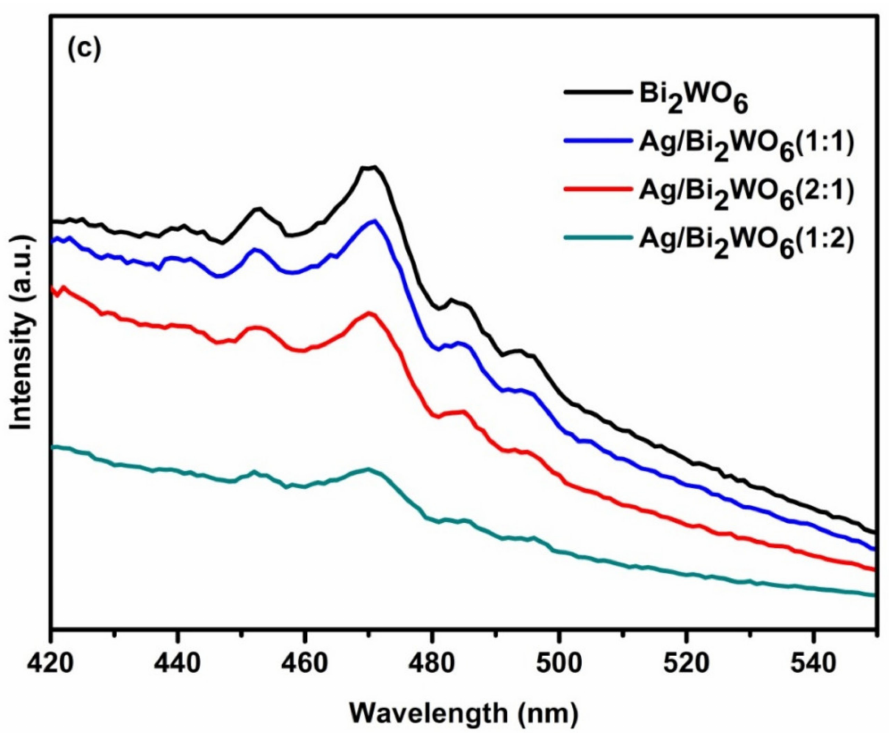
Figure 12. ( a ) Absorbance spectra, ( b ) optical band gap and ( c ) PL spectra of pure Bi 2 WO 6 and Ag/Bi 2 WO 6 (1:1, 1:2 and